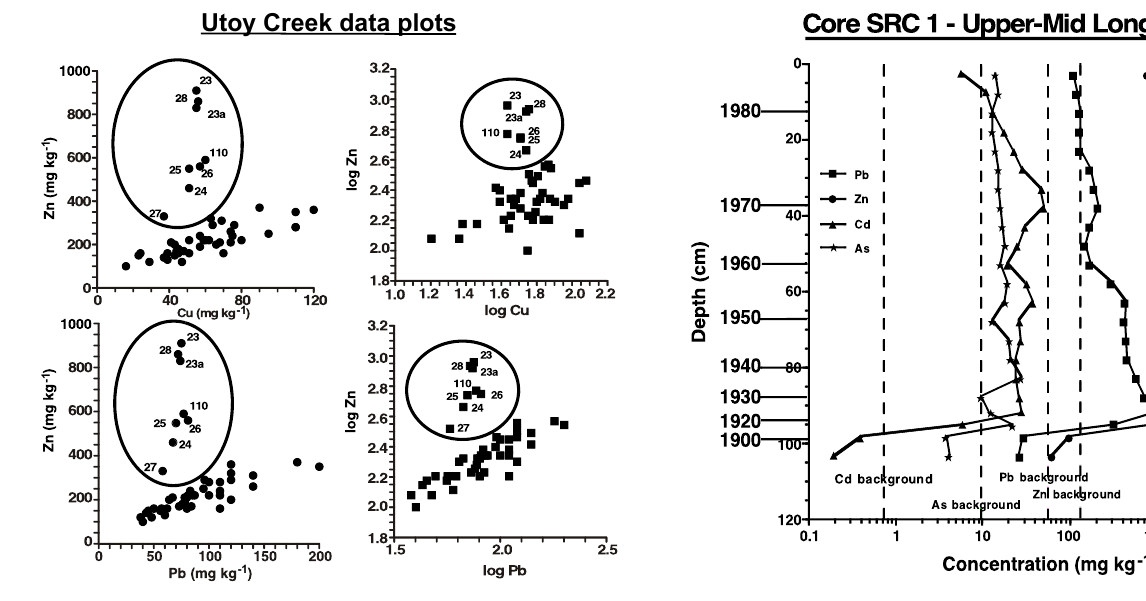
Figure 1. Plots of chemical data from the <63µm fraction of bed sediments from Utoy Creek, Georgia, USA. There are similar plots for Zn/Fe, Zn/TOC, Zn/Al, and Zn/Co.